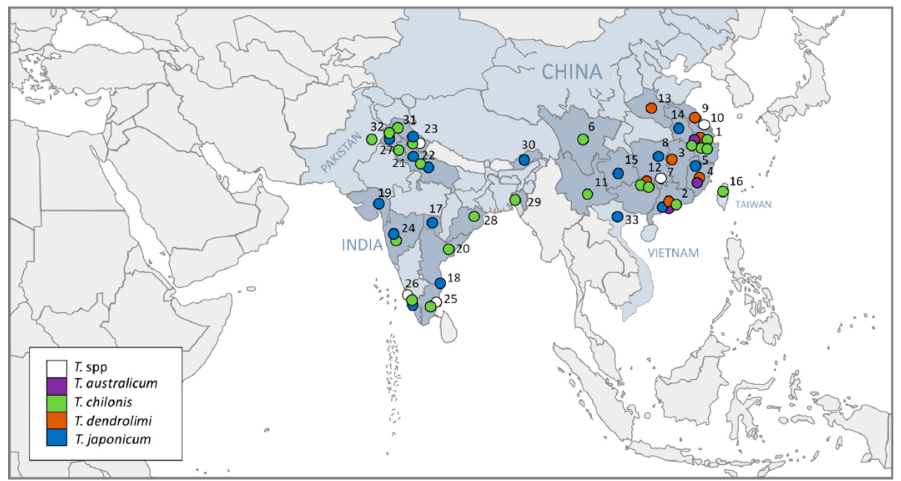
Figure 1. Locations of published case studies that used Trichogramma spp. as biological control agents against leaffolders in rice. Symbol colors indicate the Trichogramma spp. released. CHINA–1: